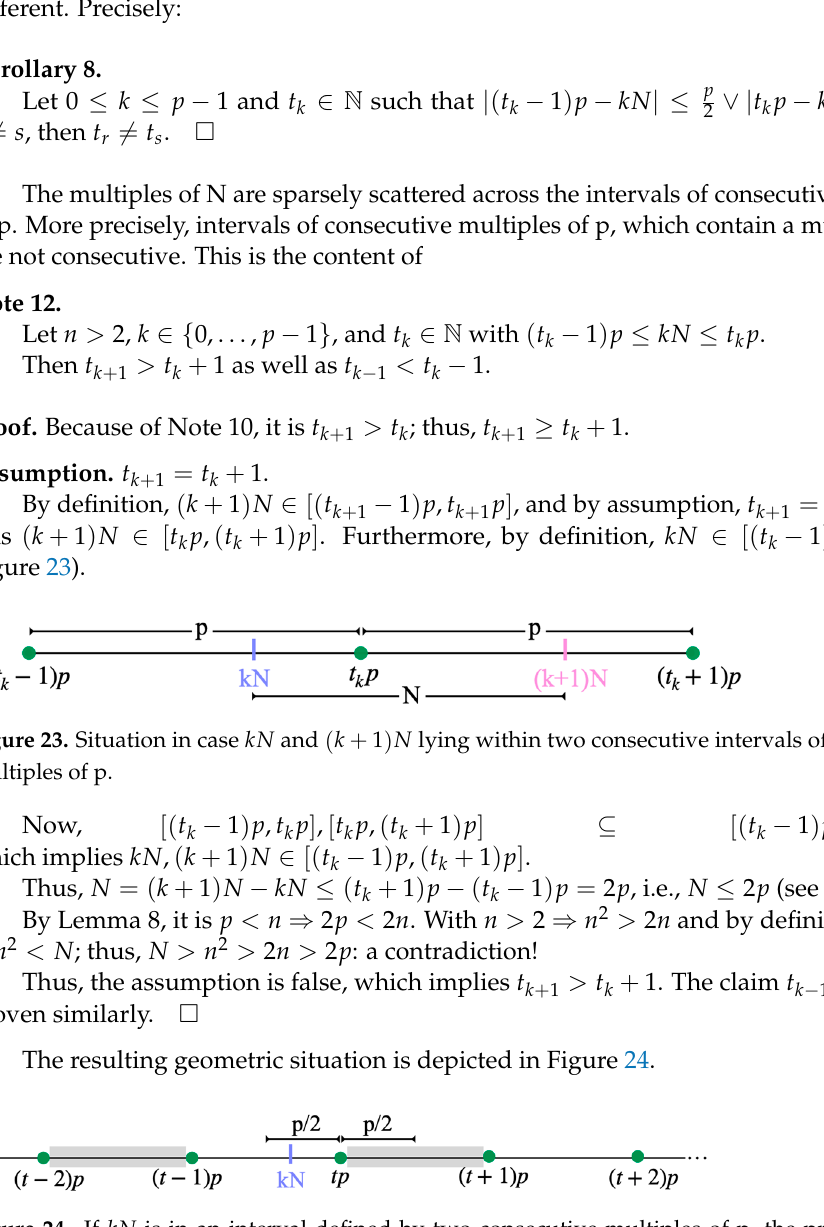
Figure 24. If kN is in an interval defined by two consecutive multiples of p, the preceding and succeeding intervals do not contain a multiple of N.